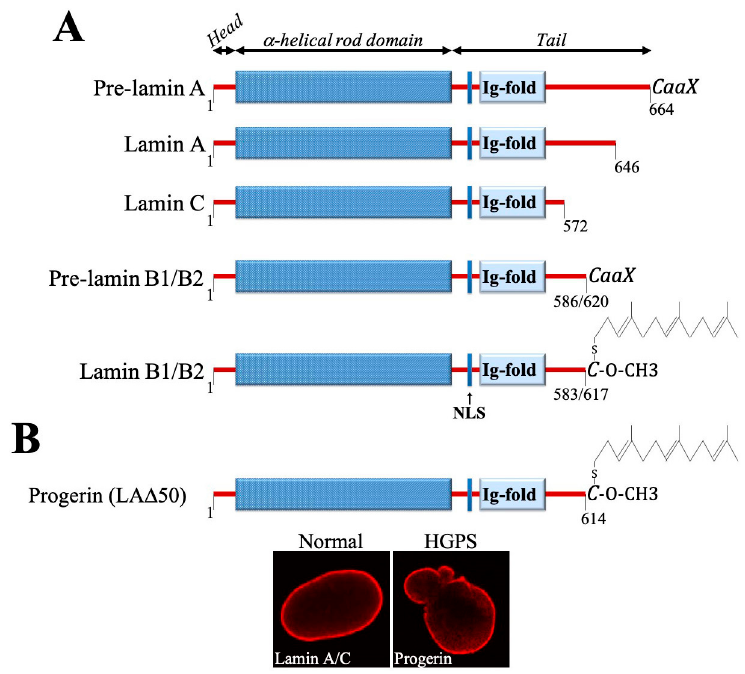
Figure 1. ( A ) Schematic diagram of domain composition and the presence of CaaX motif in nuclear lamins. NLS, nuclear localization signal. ( B ) Progerin, a mutant form of lamin A, lacks 50 amino acids in the C-terminus and therefore cannot be properly processed, retaining the carboxyl-terminal farnesyl-cysteine-methyl-ester. The morphological view of normal and HGPS cell nuclei is shown on the bottom. The images derived from [10].